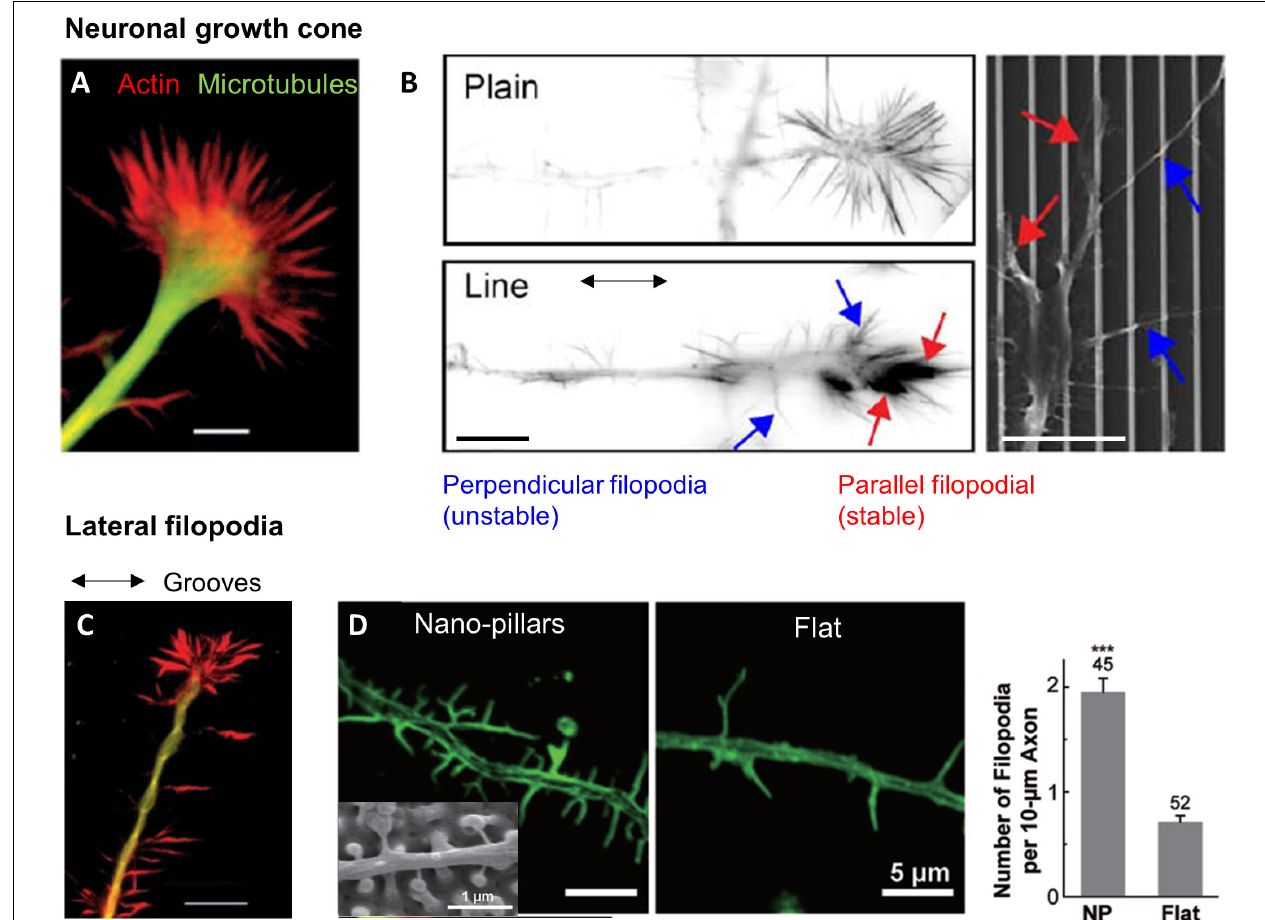
FIGURE 5 | Topography sensing in neuronal cells. (A) Structure of a neuronal growth cone (GC). Scale 5 µ m. Reproduced with permission from Rajnicek and McCaig (1997). (B) Growth cone filopodia on flat or grooved substrate. GC on grooves show two population of filopodia: parallel or perpendicular. Scale 10 µ m. From Jang et al. (2010). (C) Lateral filopodia along grooves from the neurite shaft on perpendicularly oriented neurites. Scale 10 µ m. Reproduced with permission from Rajnicek and McCaig (1997). (D) Increased number of lateral filopodia on hippocampal neurites on nano-pillars. Reproduced with permission from Seo et al. (2018). The *** correspond to the p -value of the t -test in between the 2 groups *** p <